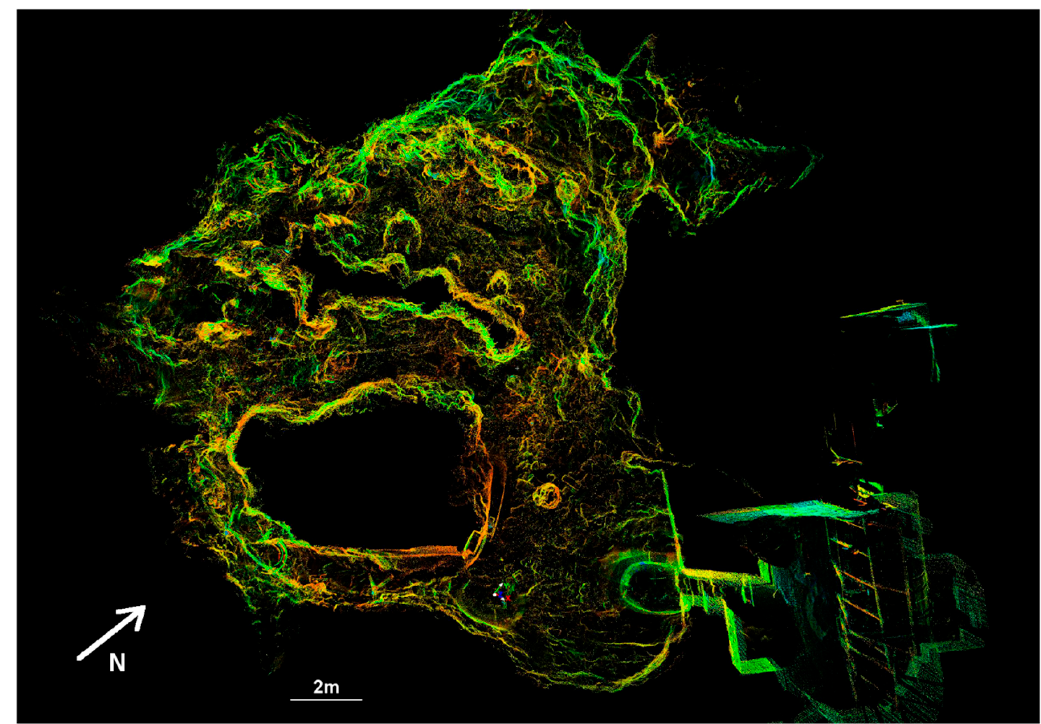
Figure 4. The cave point cloud from the above point of view: the black areas inside the cave profile show the unscanned portions that represent the columnar structures.